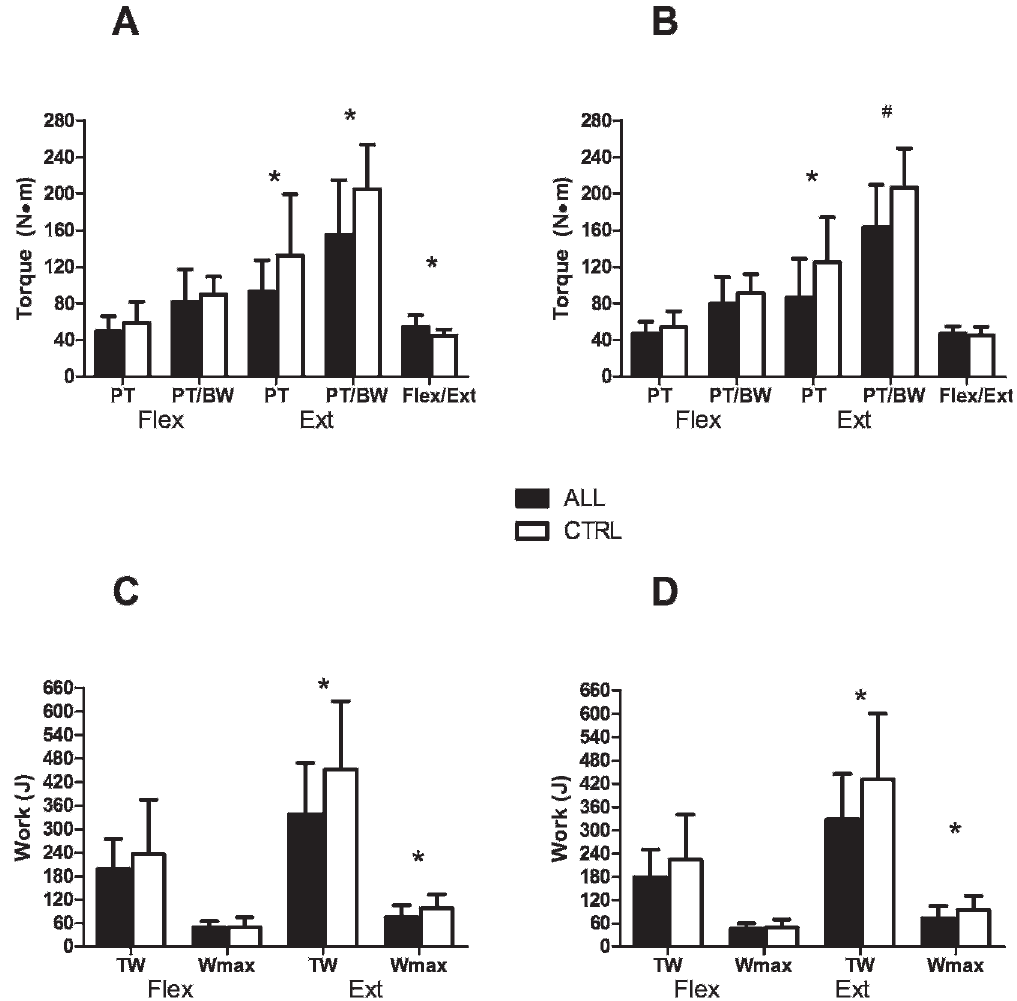
Figure 1 - Knee flexor and extensor isokinetic strength measurements for the right (panels A and C) and left (panels B and D) limbs. PT, peak torque; PT/BW, peak torque normalized to body weight; Flex/Ext, balance between flexors and extensors; TW, total work; Wmax, maximum work performed during a single repetition. *, p # 0.05 for between-group comparisons. # , p =0.06 for